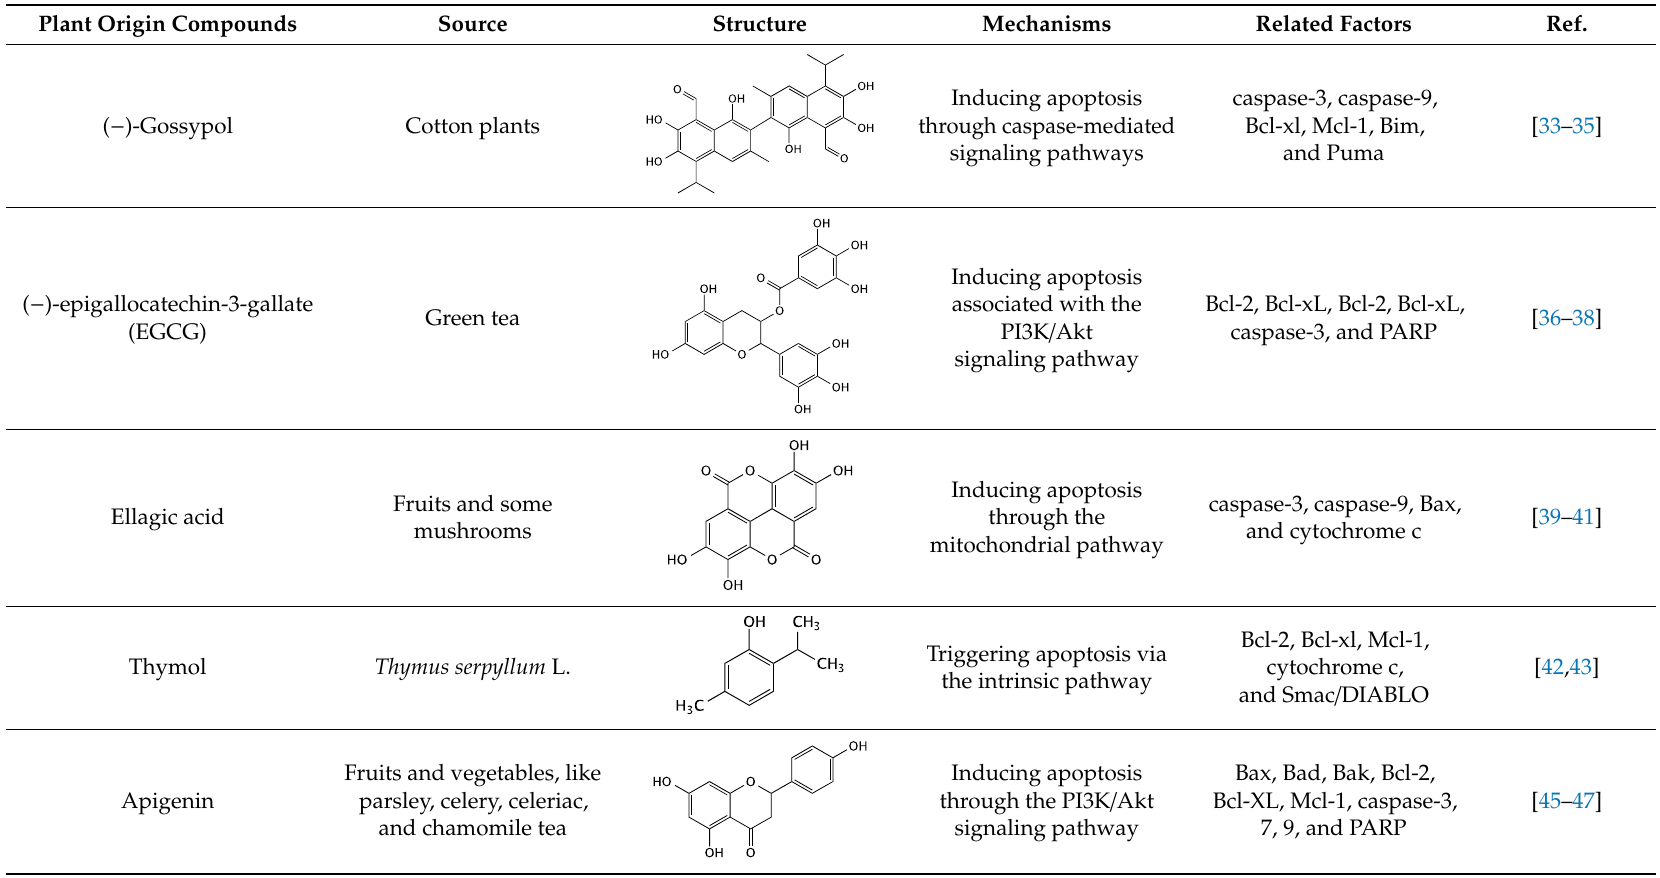
Table 1. Promising plant origin natural products for bladder cancer therapy.